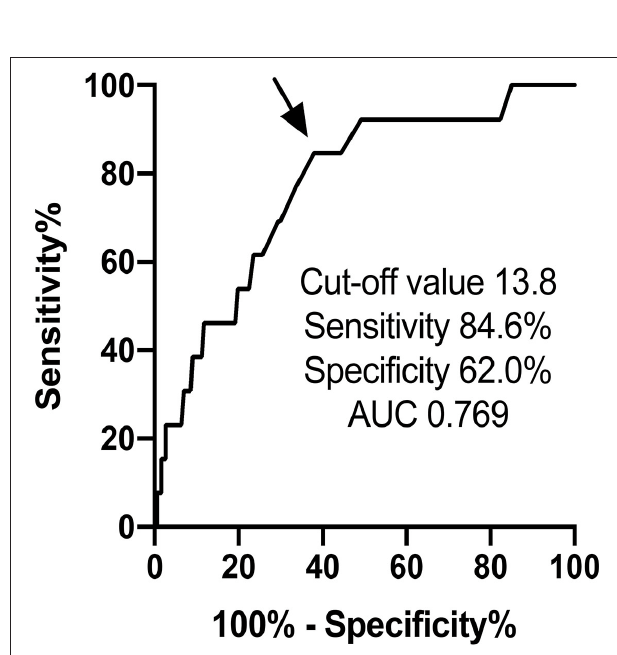
FIGURE 3 | ROC curve analysis of RDW predicting the occurrence of CTRCD by